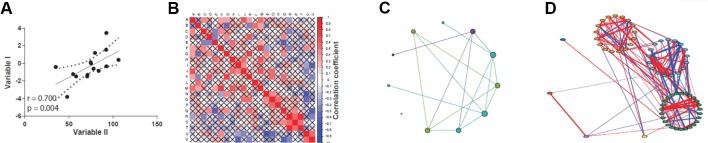
Different views on assessing correlations. (A) Classic scatter plot with correlation curve (straight black line). (B) Correlation matrix plot, designed with the corrplot package (Wei and Simko, 2017). (C) Circular layout correlation network, designed with Gephi (Bastian et al., 2009). (D) Complex correlation network with modularity coloring, designed with qgraph package (Espkamp et al., 2012).